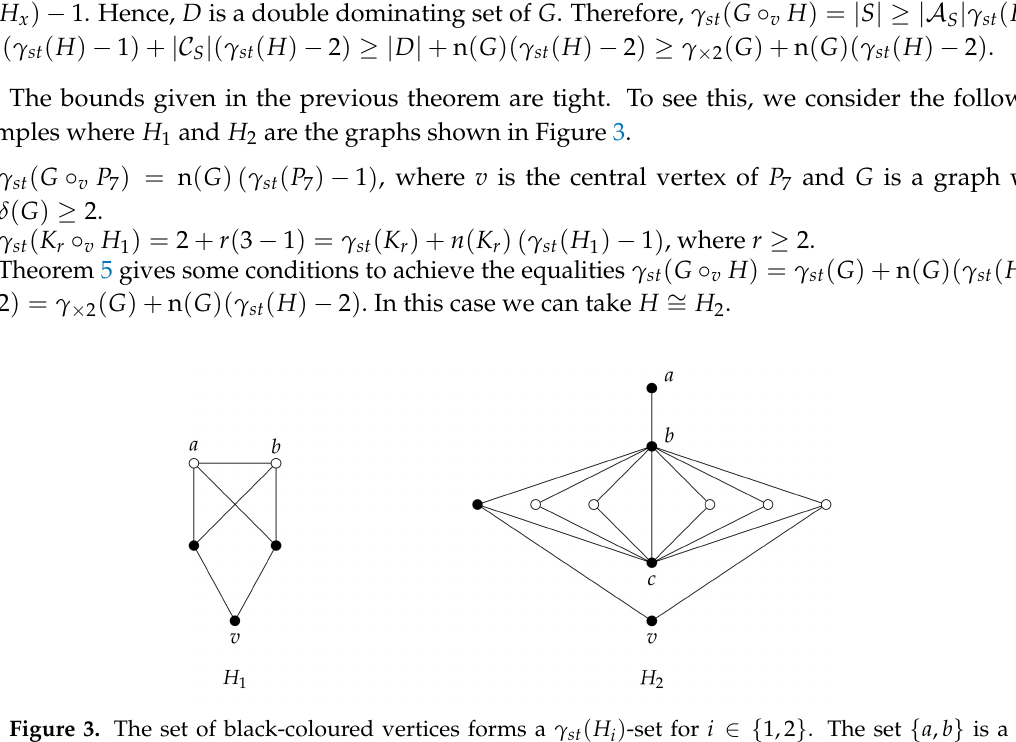
Figure 3. The set of black-coloured vertices forms a γ st ( H i ) -set for i ∈ { 1,2 } . The set { a , b } is a γ st ( H 1 − { v } ) -set, while { a , b , c } is a γ st ( H 2 − { v } )